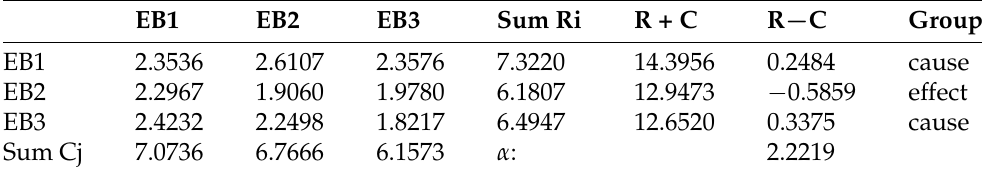
Table 13. Total relation and direct–indirect influence matrix for environmental